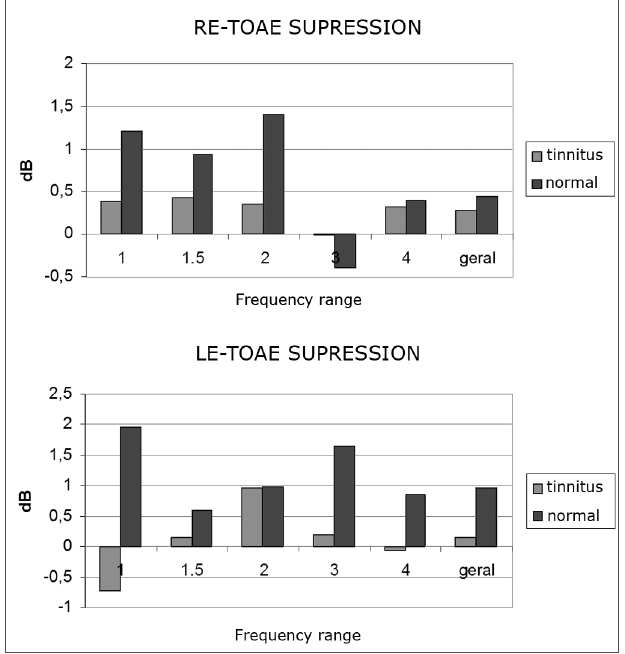
Graphs 3 and 4. Mean TEOAE amplitude suppression per frequency range for right and left ears in the tinnitus (n= 20) and tinnitus-free (n= 20) groups.